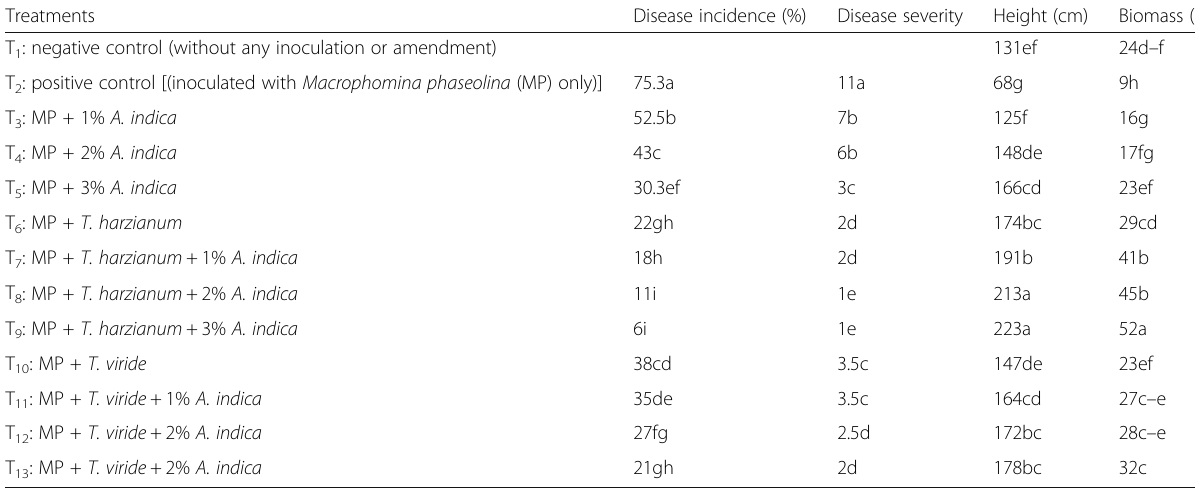
Table 3 Effect of Macrophomina phaseolina , soil amendment, and Trichoderma spp. on disease and growth and dry weight of Vigna unguiculata